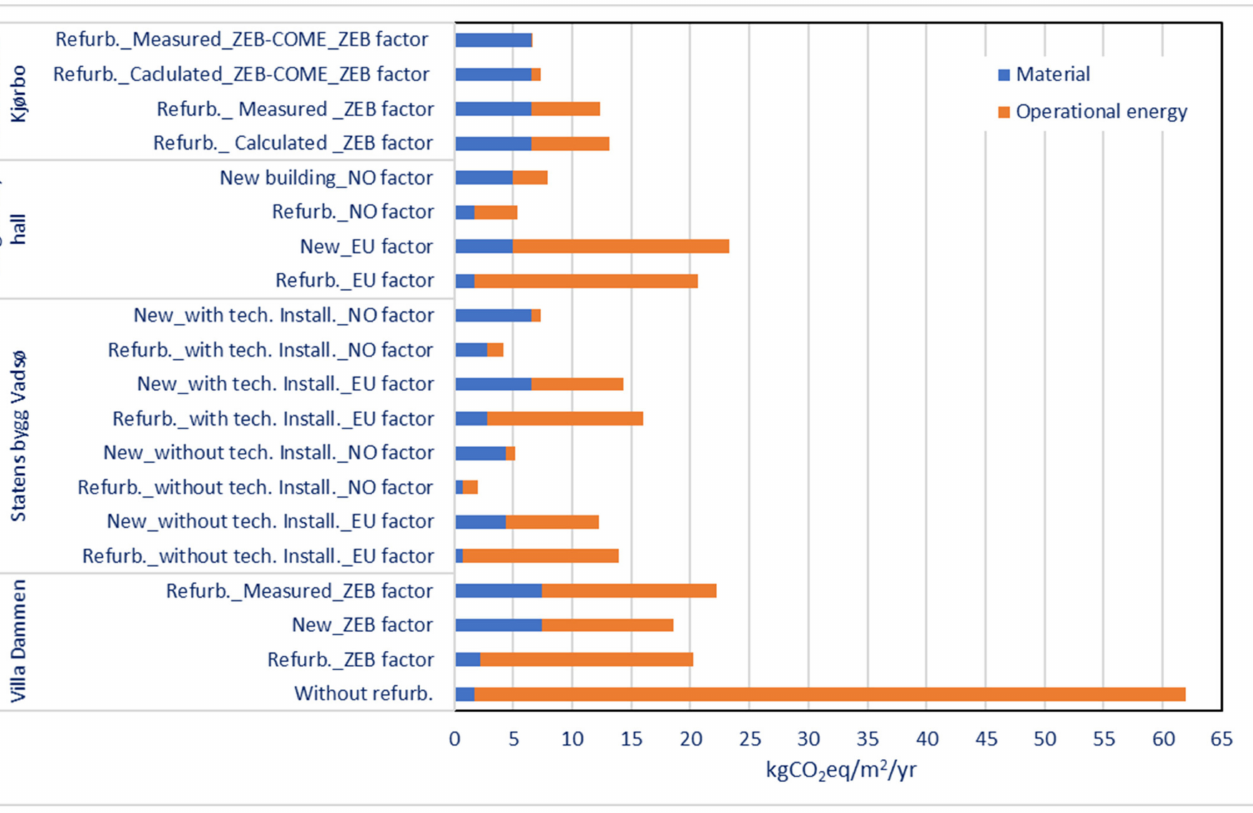
Figure 3. Scenario